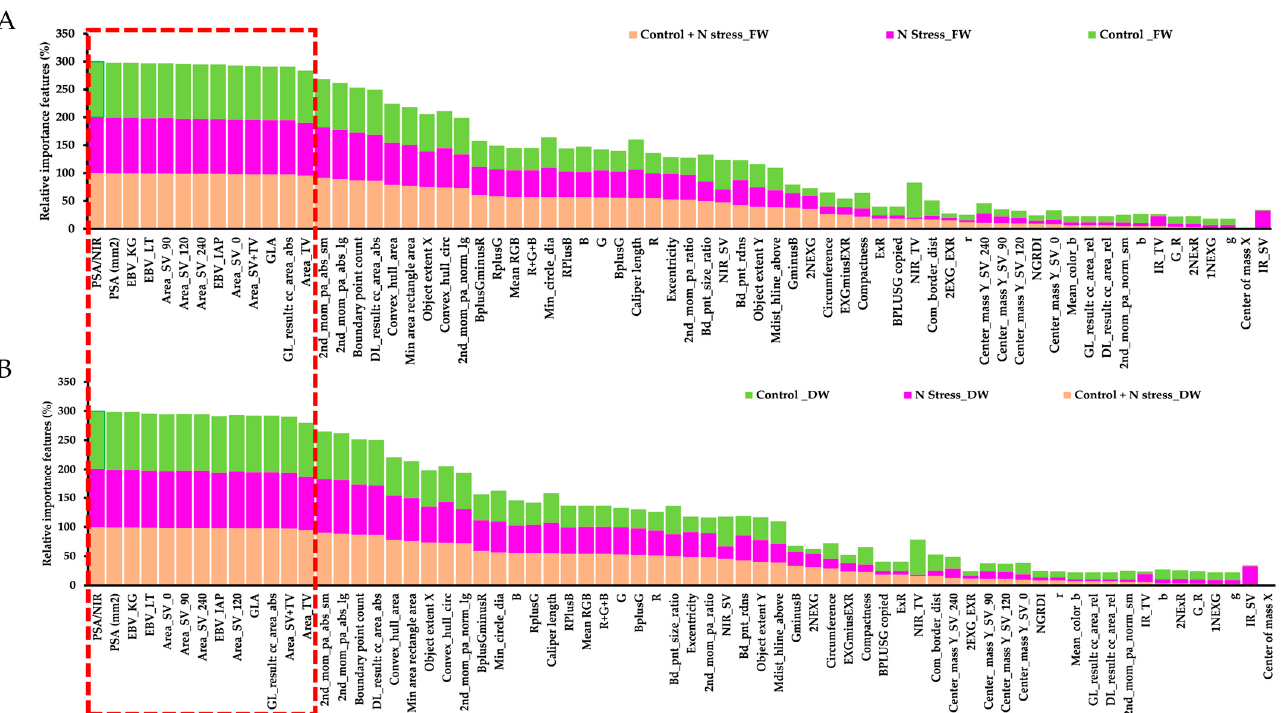
Figure 5. Cluster column chart showing the relative importance of i-traits in predicting FW and DW using BRNN and BLASSO models. Relative importance of image-derived features in predicting FW ( A ) and DW ( B ). The features highlighted in the red dash box are PSA: NIR, PSA, EBV_KG, EBV_LT and